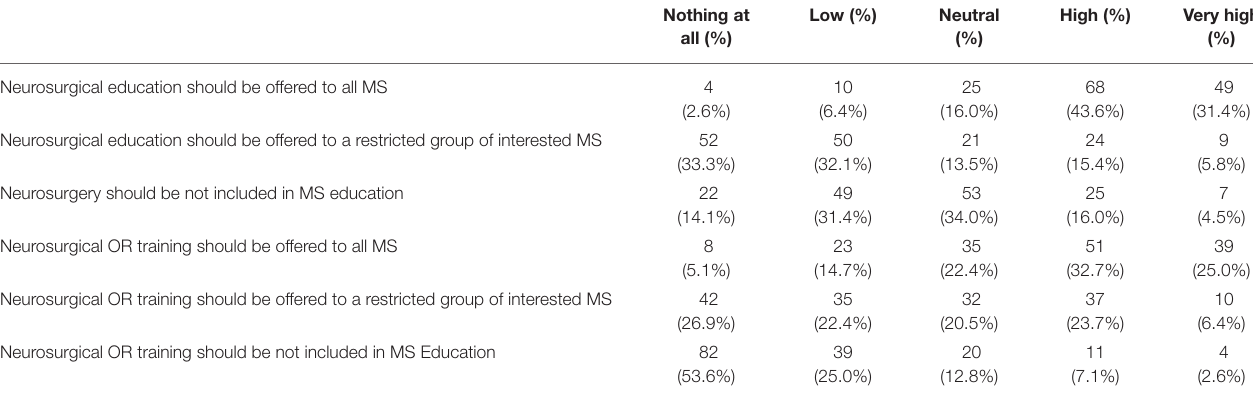
TABLE 4 | Role of neurosurgical education and training in medical school.